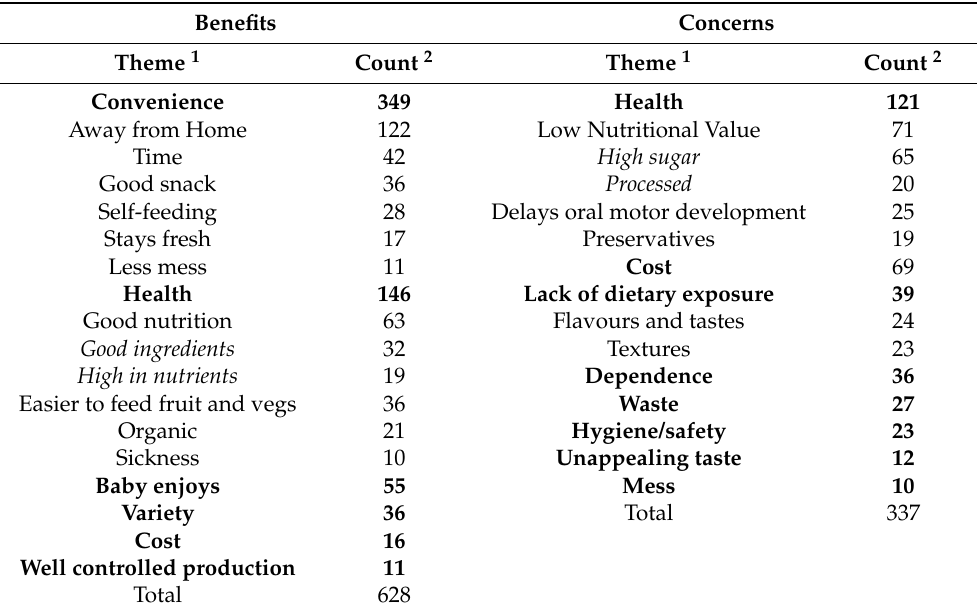
Table 1. Parental attitudes regarding benefits and concerns of baby food pouch use across fo- rum thread.